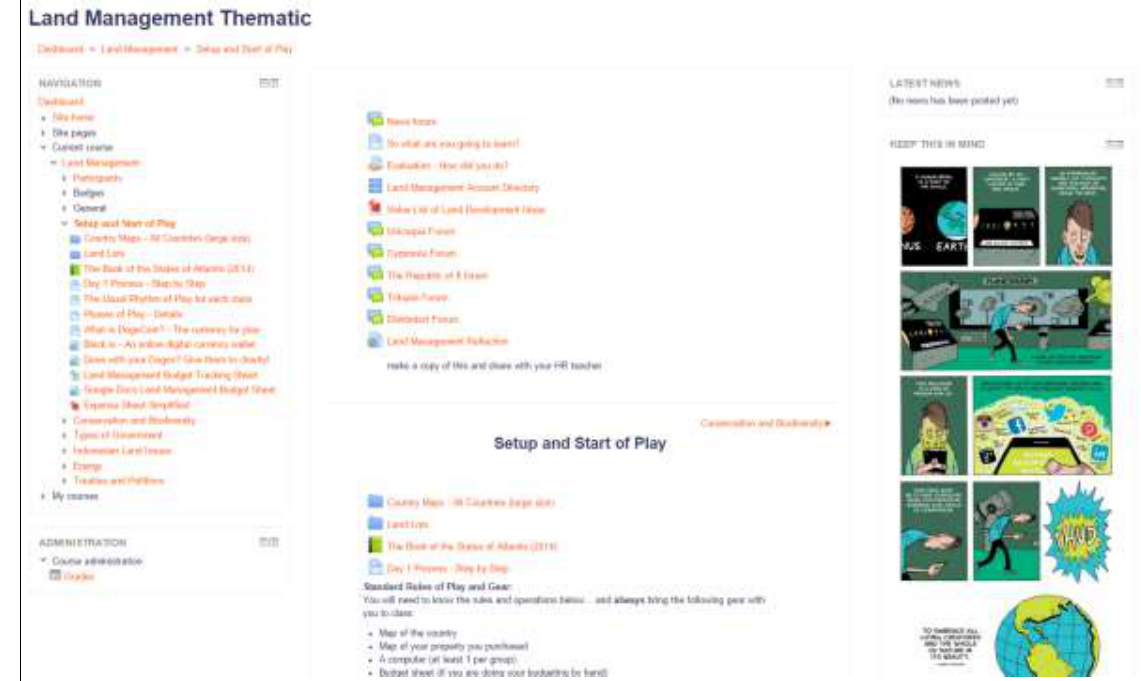
Figure 1. View of Moodle virtual